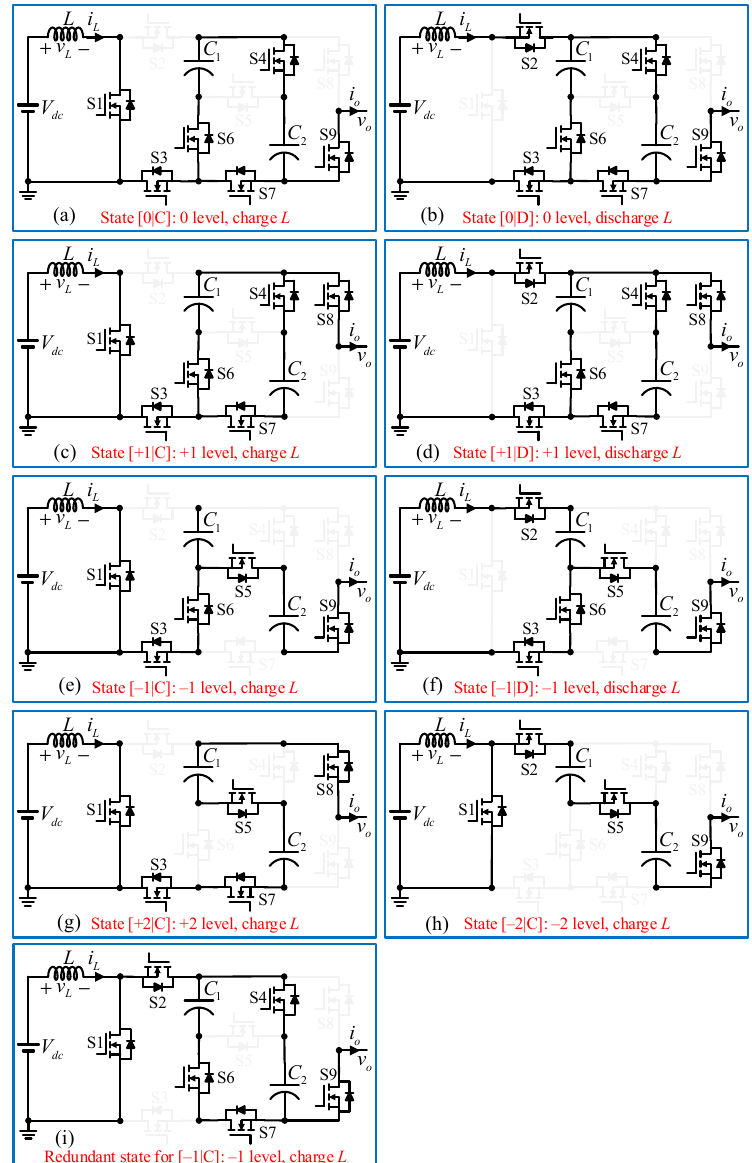
Figure 2 . Different modes of operation of the proposed inverter. Figure 2. Different modes of operation of the proposed The inductor is simultaneously charged in every switching period with a constant duty cycle ( D) that boosts the capacitor’s voltage across C 1 and C 2 , and the average volt- age across capacitors C 1 and C 2 is obtained as follows: